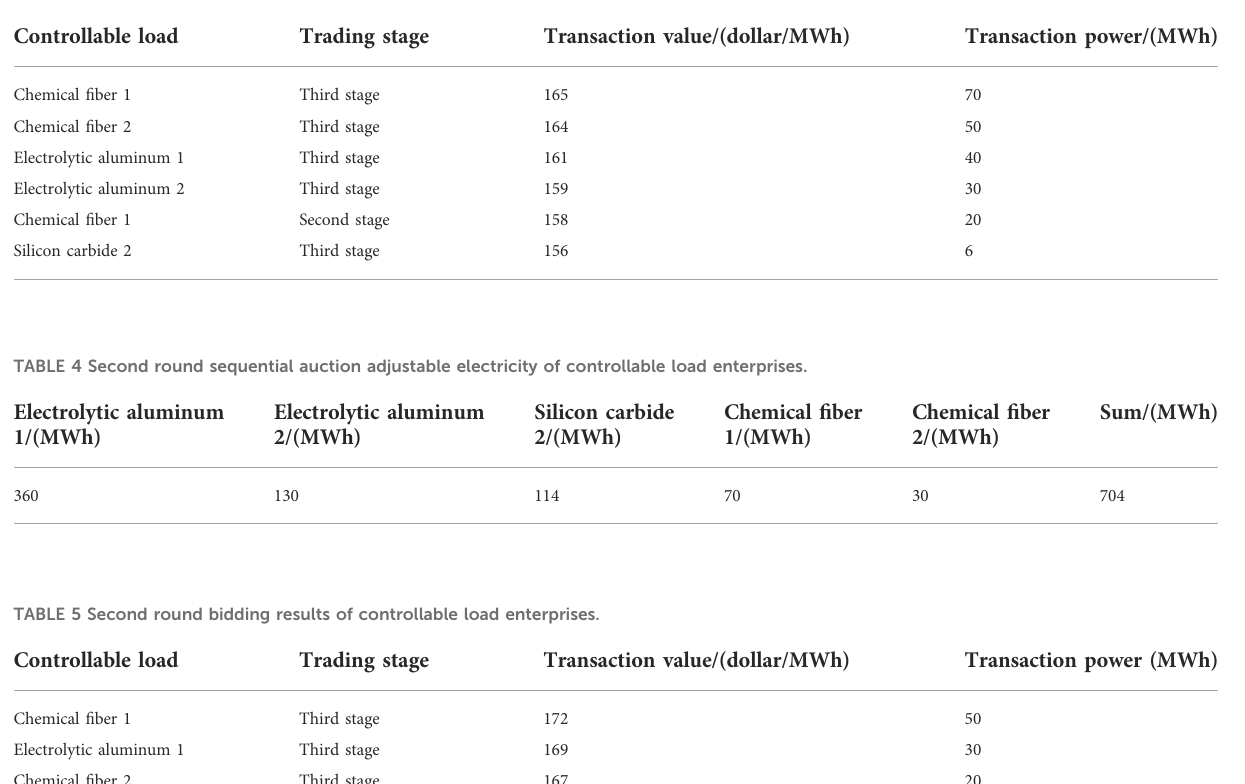
TABLE 3 First round bidding results of controllable load enterprises.